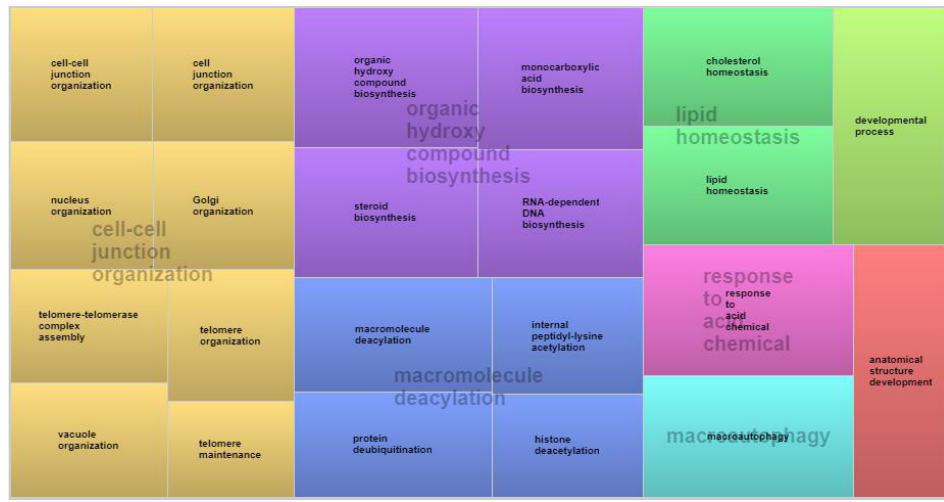
Figure 2. Analysis of biological processes co-associated with body conformation evaluated based on visual scores in Nellore cattle.